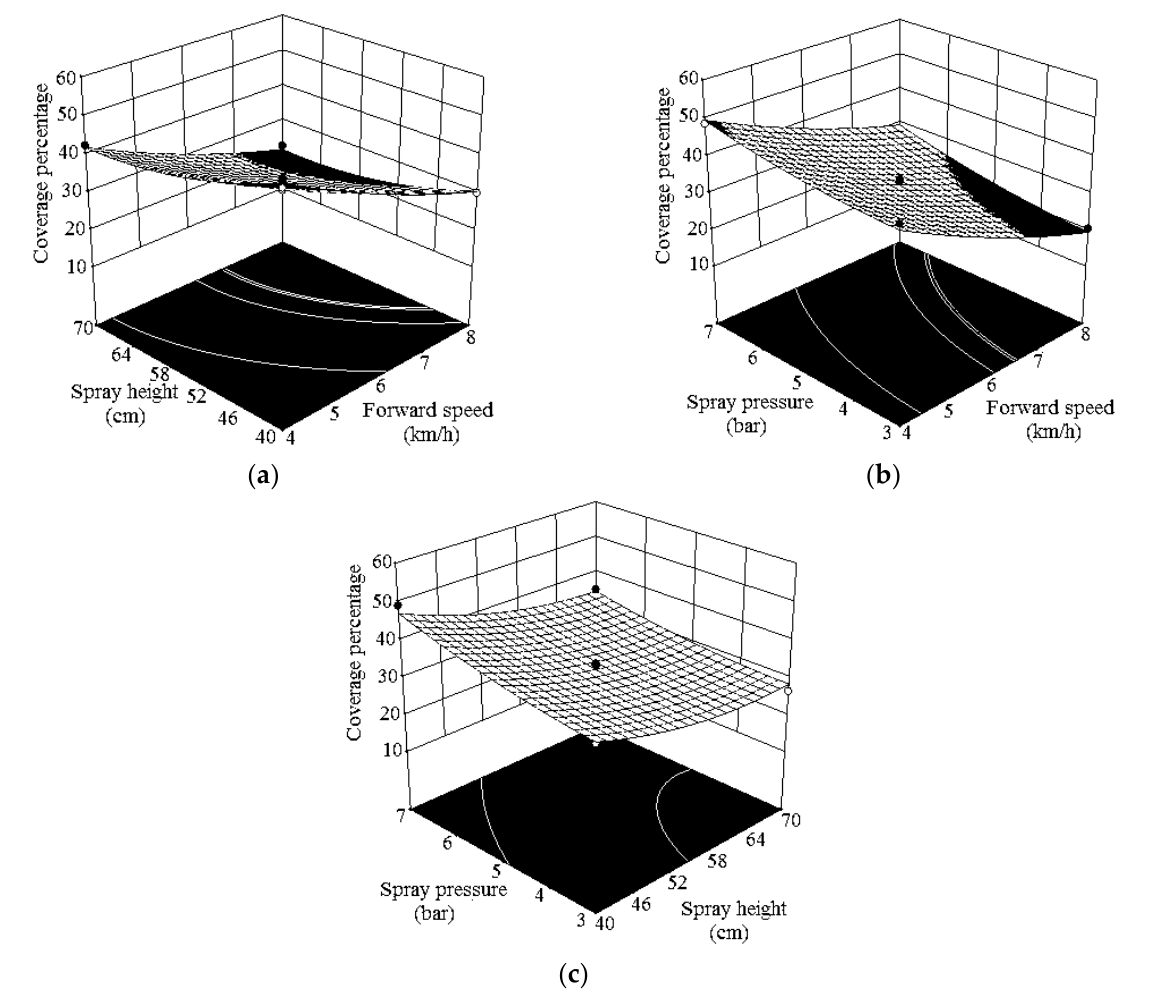
Figure 10. Three-dimensional surface map for droplet density: ( a ) interaction effect of forward speed and spray height at 5 bar pressure; ( b ) interaction effect of forward speed and spray pressure at 55 cm height; ( c ) interaction effect of spray height and spray pressure at 6 km/h speed.